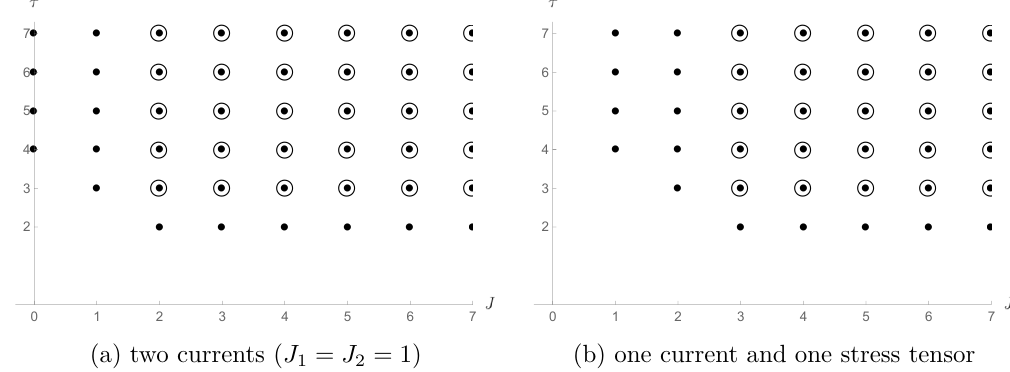
(b) one current and one stress tensor Figure 3. Spectrum of double-twist operators of the form [ JJ ] n,J and [ JT ] n,J . Double circles indicate multiplicity: there is a single trajectory for n = 0 and two for each n ≥ 1